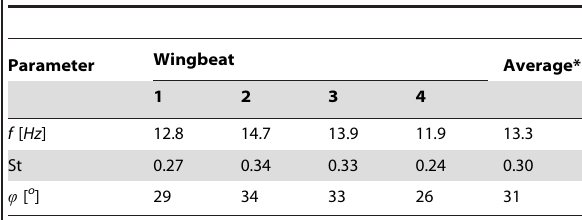
Table 1. The wingbeat frequency, Strouhal number and the wingtip angle of attack for the four wingbeat